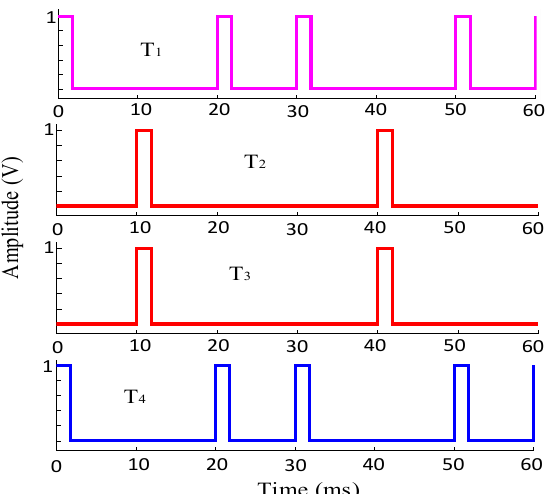
Figure 5. Cycloconverter detailed operation of the eight modes for (1/3) and (1/4) frequency conversion of input frequency.